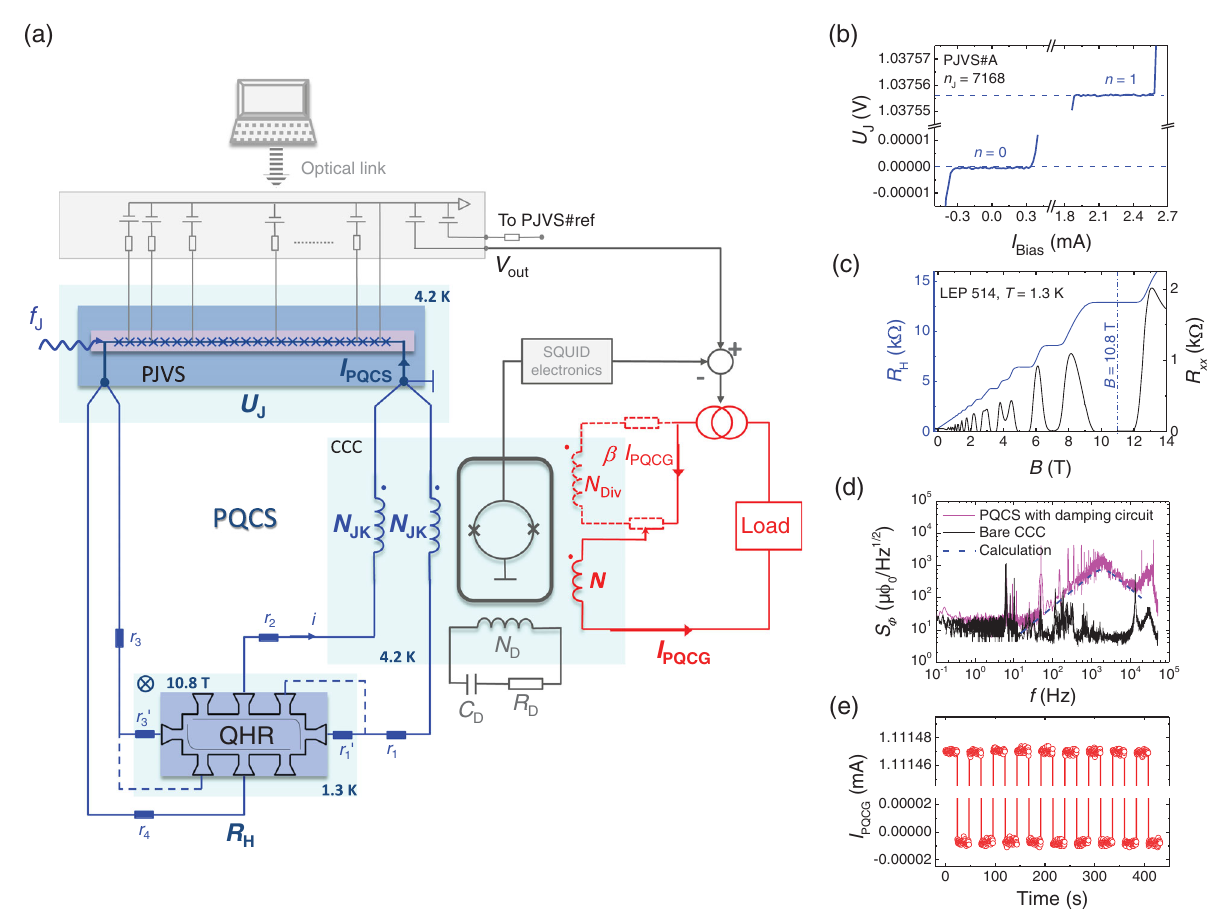
FIG. 2. Experimental realization of the PQCG. (a) The PQCS is composed of a PJVS biasing a QHRS through double connections, each one incorporating a cryogenic current comparator (CCC) winding ( N turns) on the low potential side. A third terminal (dotted JK line) connected at the top of the QHE setup further reduces the cable contribution to the current I . The current I of the PQCG, PQCS PQCG generated by an external current source into a winding of N turns, is synchronized and coarsely adjusted by the PJVS programmable bias source using V . Note that I is locked to the current I of the PQCS by means of the CCC, which is used as an accurate adder out PQCG PQCS =N gain. A current divider injecting a fraction β of I amplifier of N in a CCC winding of N ( ¼ 16 turns) allows a fine-tuning of JK PQCG Div the CCC amplification gain. The damping circuit formed by a 100-nF highly insulated Polytetrafluoroethylene (PTFE) capacitance in series with a 1 . 1 -k Ω resistor is connected to a CCC winding of N ( ¼ 1600 ) turns. (b) PJVS#A output voltage as a function of the bias D 70 GHz and T ¼ 4 . 2 K. (c) Hall resistance R current I for the total number of Josephson junctions at f and longitudinal Bias J ¼ H resistance R xx measured, using a current of 10 μ A at T ¼ 1 . 3 K, as a function of B in the GaAs = AlGaAs-based Hall bar device (LEP514). The device is used at B ¼ 10 . 8 T. (d) The noise amplitude spectral density (expressed in μϕ 0 = Hz 1 = 2 ), measured at the output of the SQUID in internal feedback mode, for the CCC alone (black) and the CCC connected to the PQCS and the damping circuit (magenta) without the external current source. (e) Series of on-off switchings of the current I recorded on a digital ammeter (at PQCG 3073 , N 129 , and N ¼ 4 1.1 mA), obtained for n J ¼ JK ¼